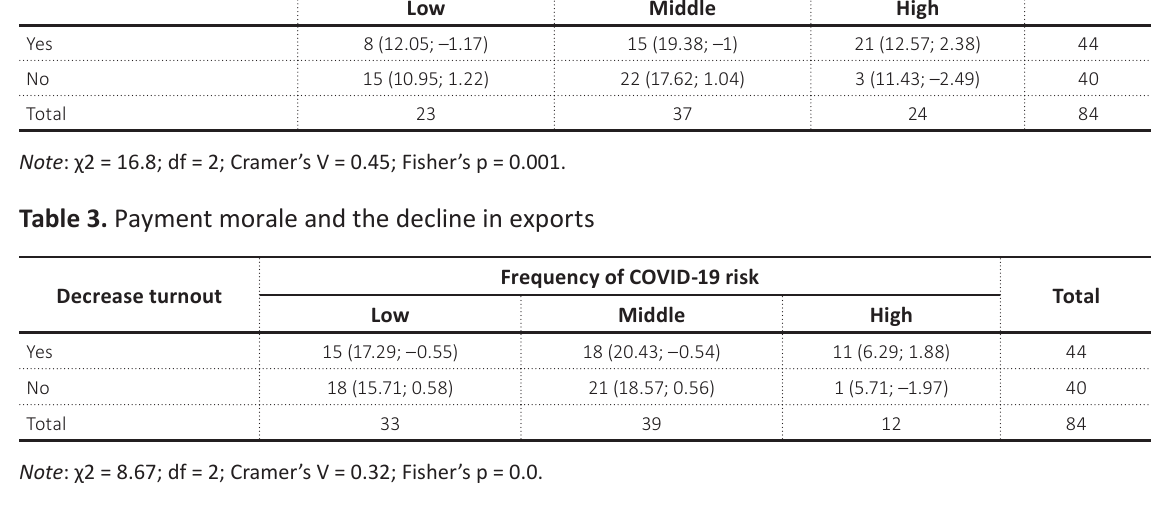
Table 2. COVID-19 risks and the decline in exports Decrease turnout